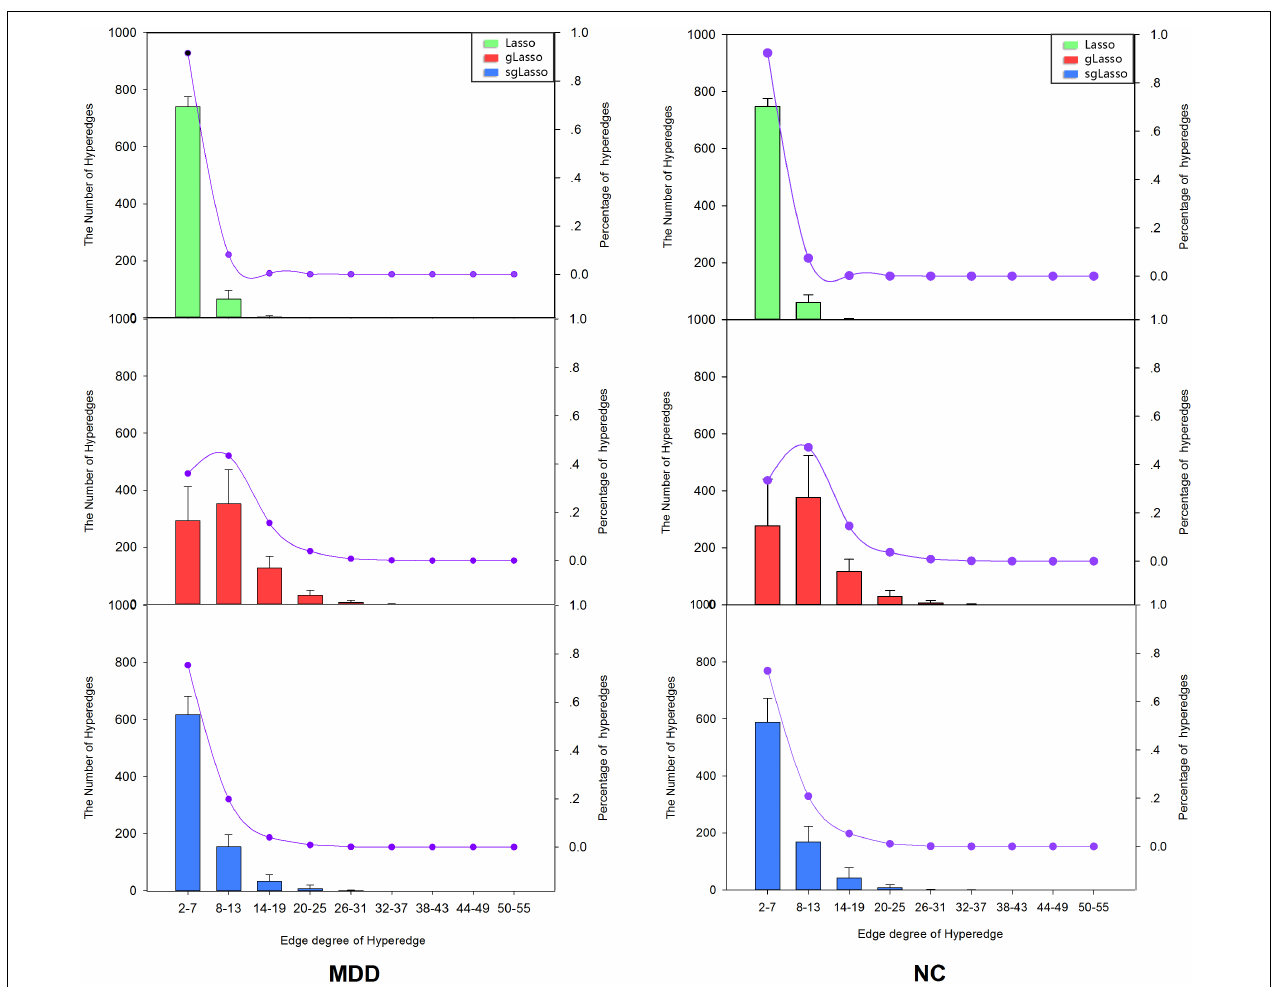
FIGURE 2 | The distribution of the edge degree about hypernetwork obtained by three